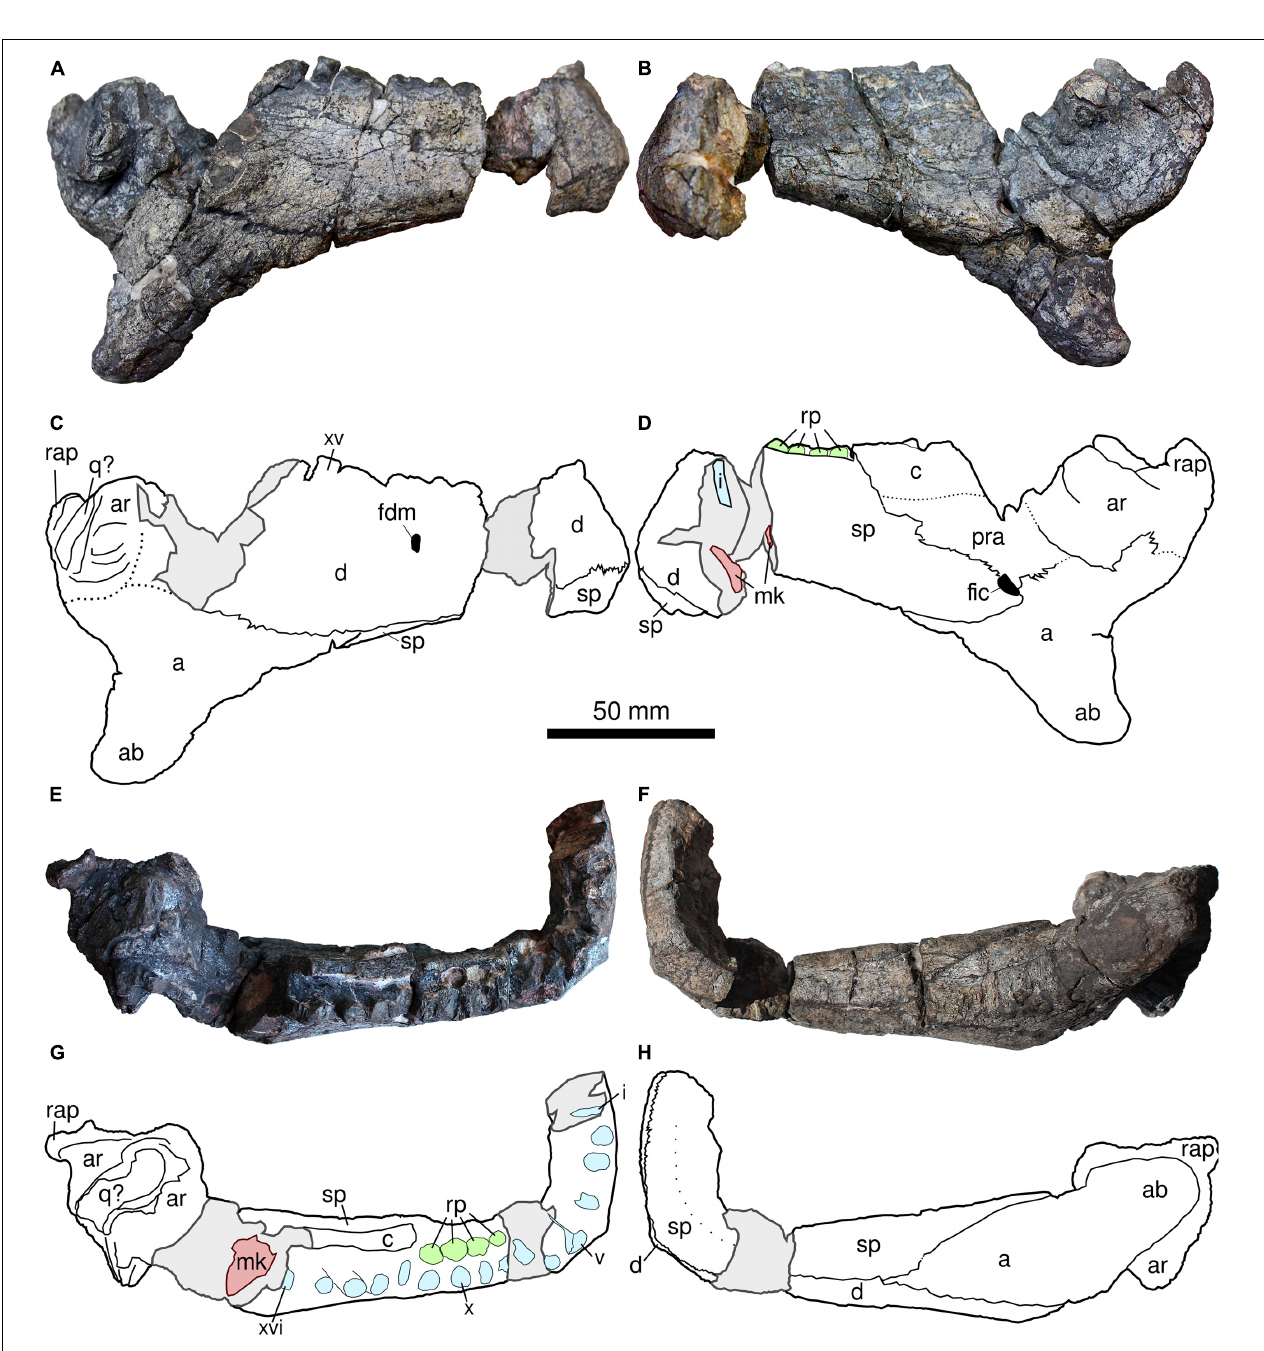
FIGURE 6 | UFRGS-PV-0359-P, right hemimandible of Provelosaurus americanus . (A,C) Lateral view; (B,D) medial view; (E,G) occlusal view; (F,H) ventral view. a, angular; ab, angular boss; ar, articular; c, coronoid; d, dentary; fdm, foramen dentofaciale majus; fic, foramen intermandibularis caudalis; mk, Meckelian canal; q, quadrate; rap, retroarticular process; rp, resorption pit; sp, splenial; i–xvi, tooth positions.